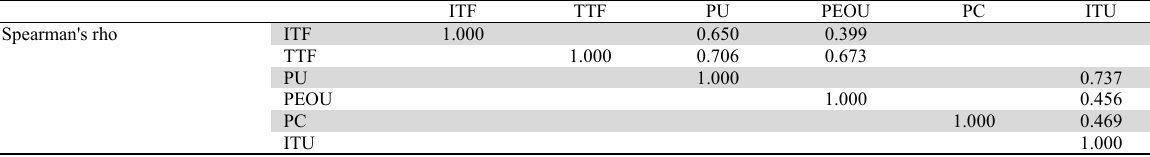
The result of the matrix correlation coefficient using Spearman's Rho (N=160).